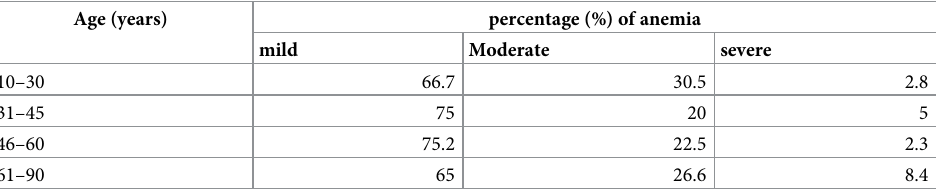
Table 2. Prevalence of mild, moderate and severe anemia by